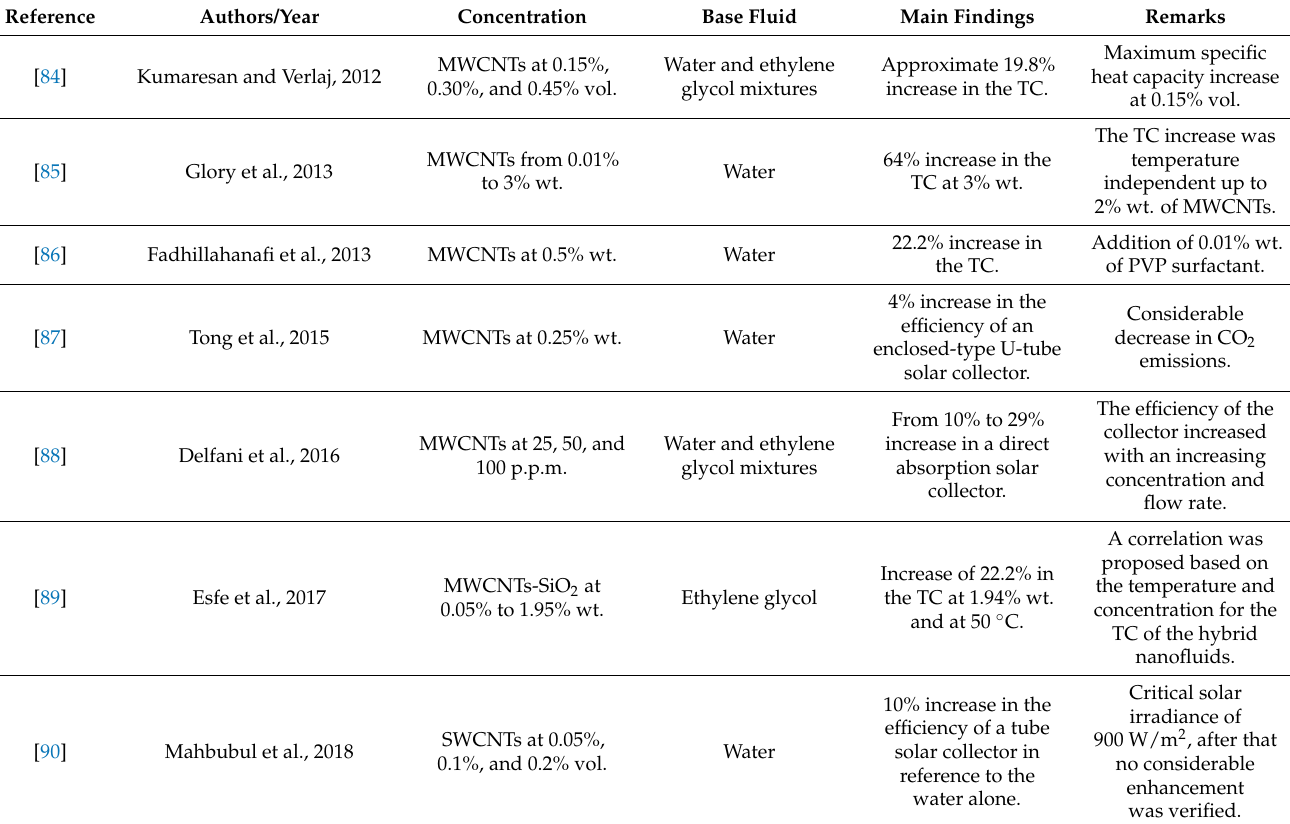
Table 3 summarizes some studies on CNT 2D nanofluids. Table 3. Some studies on 2D CNT nanofluids and